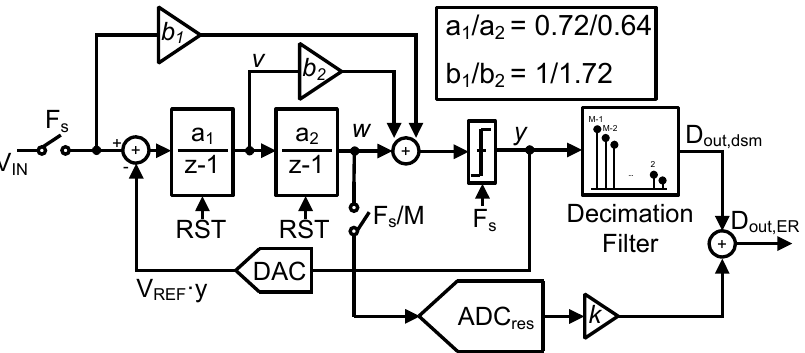
Figure 1. A block diagram of the conventional 2nd-order discrete time (DT) incremental delta-sigma modulator (IDSM) with extended range.